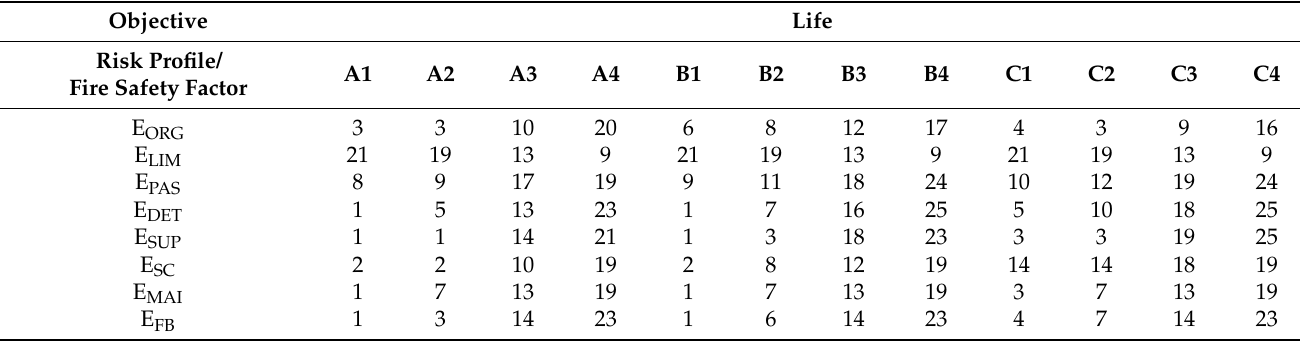
Table 3. The authors determined the default (determined by the authors based on their validation works and consultations with the Polish local authorities) scores proposed for baseline fire strategies values.